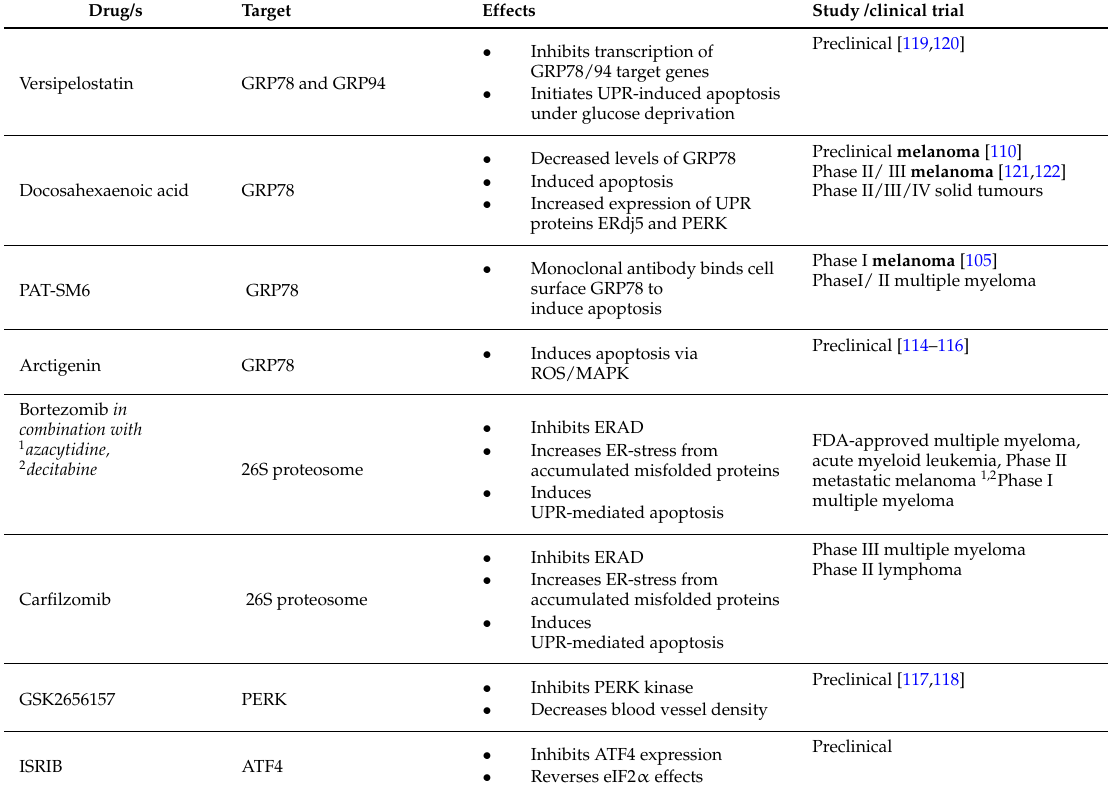
Table 1. Drug therapies targeting the UPR for the treatment of cancer. Superscript denotes combinatorial therapeutic